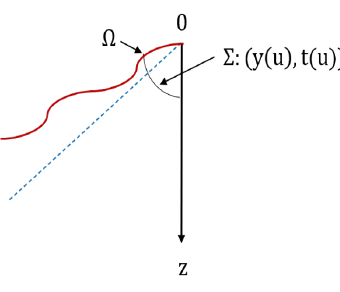
Figure 4 . Dynamical UV cut off for the wedge W 1 + ˜ W